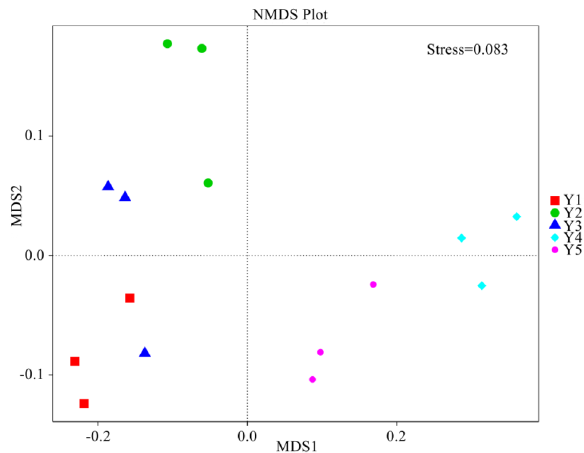
Figure 4. Non-Metric Multi-Dimensional Scaling (NMDS) analysis. The differences between the samples or the groups were expressed by the distance in figure, and the nearer distance showed the more similar bacterial community structure between the two samples. NMDS can accurately reflect the difference between samples when Stress < 0.2.